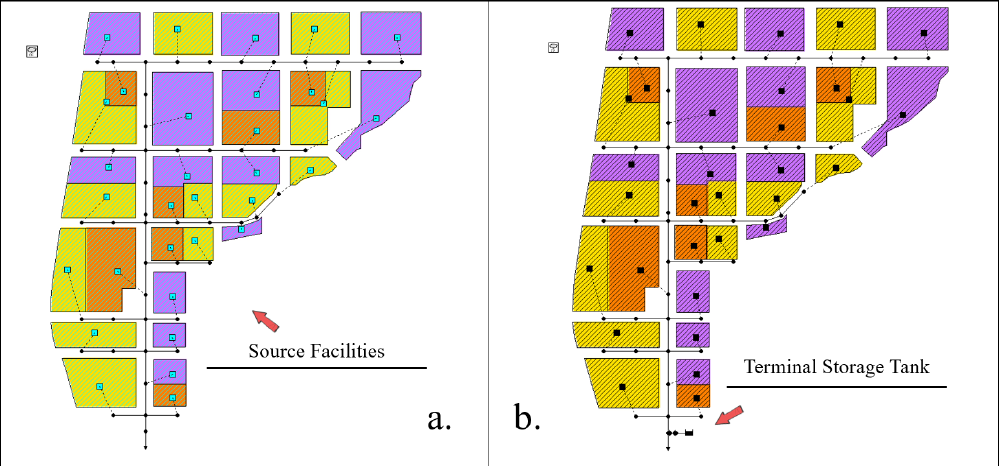
Figure 3. Runoff volume capture measures: ( a ) Source Facilities, ( b ) Terminal Storage